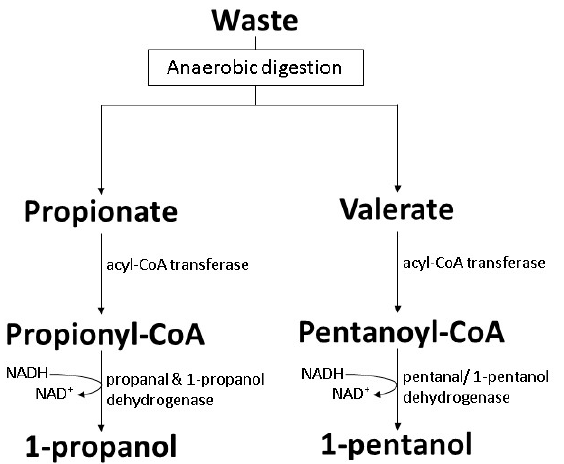
Figure 11. Biosynthesis of 1-pentanol by genetically engineered E. coli BL21(DE3 with acquired carboxylate reduction pathway [119].